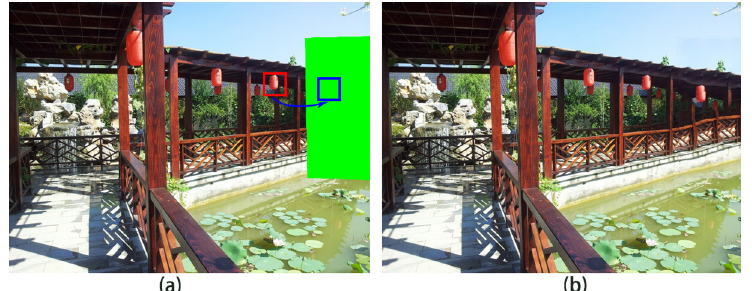
Fig 4. Inappropriate transformation for image completion: (a) inappropriate transformational source patch, (b) results of the Darabi method